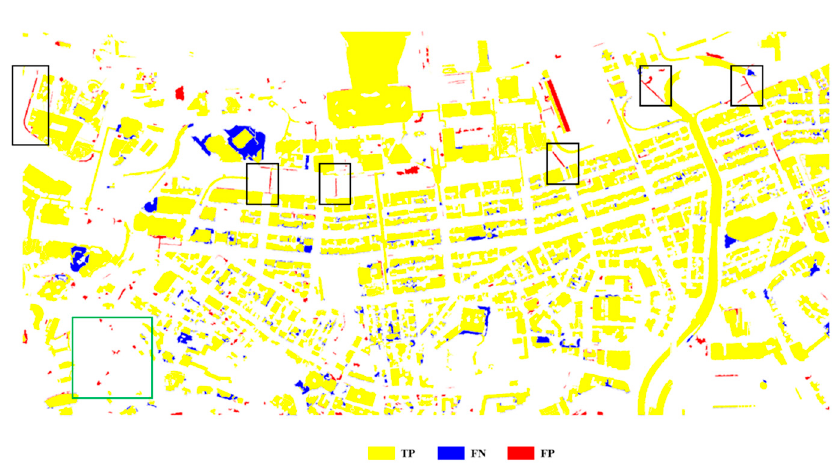
Figure 13. Semantic labeling results and visualized evaluation of the Hong Kong test sites. Table 5. Evaluations of the semantic labeling results of the Hong Kong sites using the proposed method. MPB: multi-primitive-based; HS: hierarchical strategy.